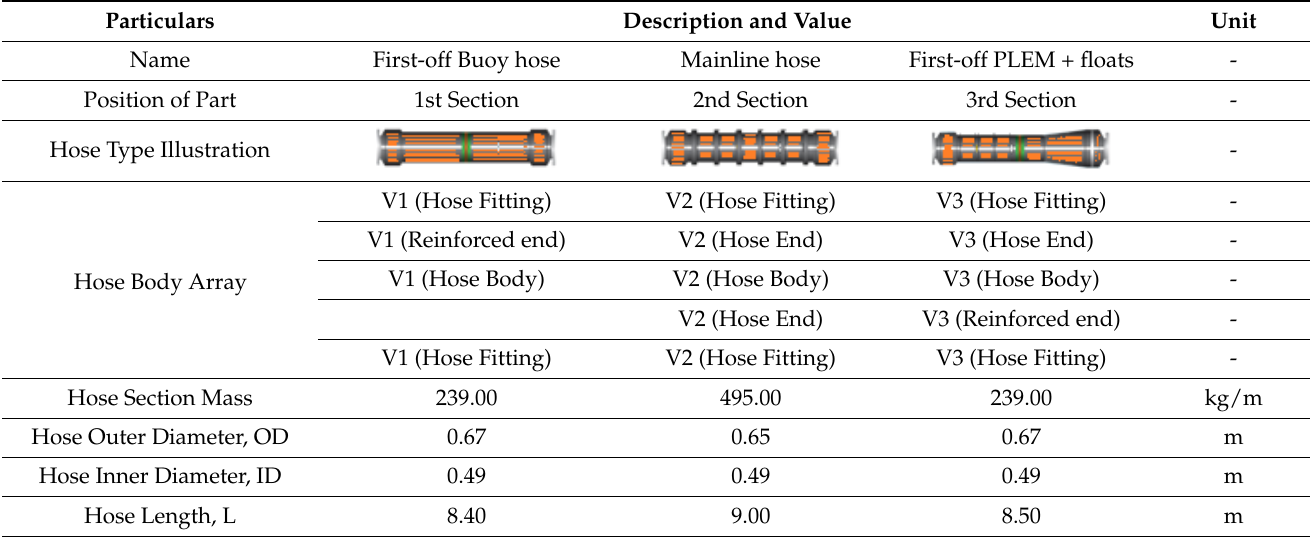
Table 2. Parameters for the submarine hose for Chinese-Lantern configuration with section details arrangement.